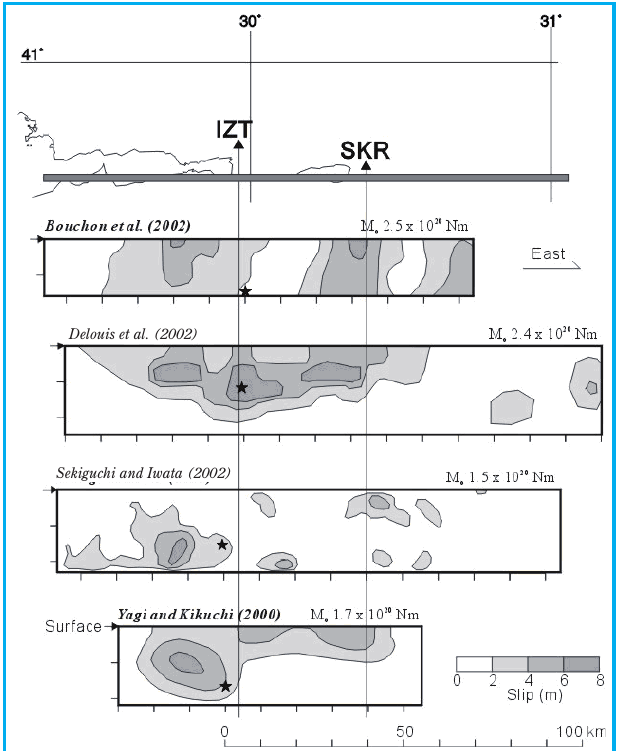
Figure 1. Slip models for the 1999 Izmit earthquake (Ide et al.,